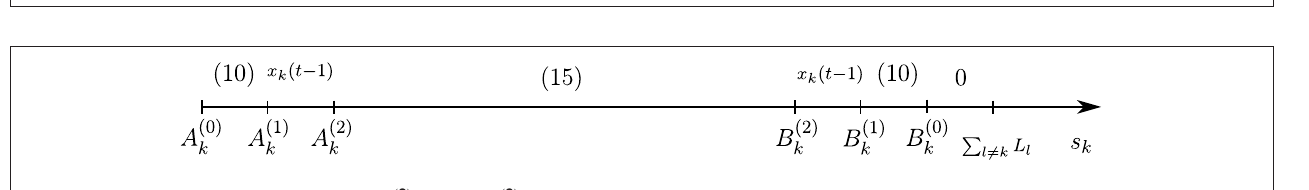
FIGURE 3 | Different segments of R k when D ( 2 ) k ≤ 0 and D ( 1 ) k > 0.